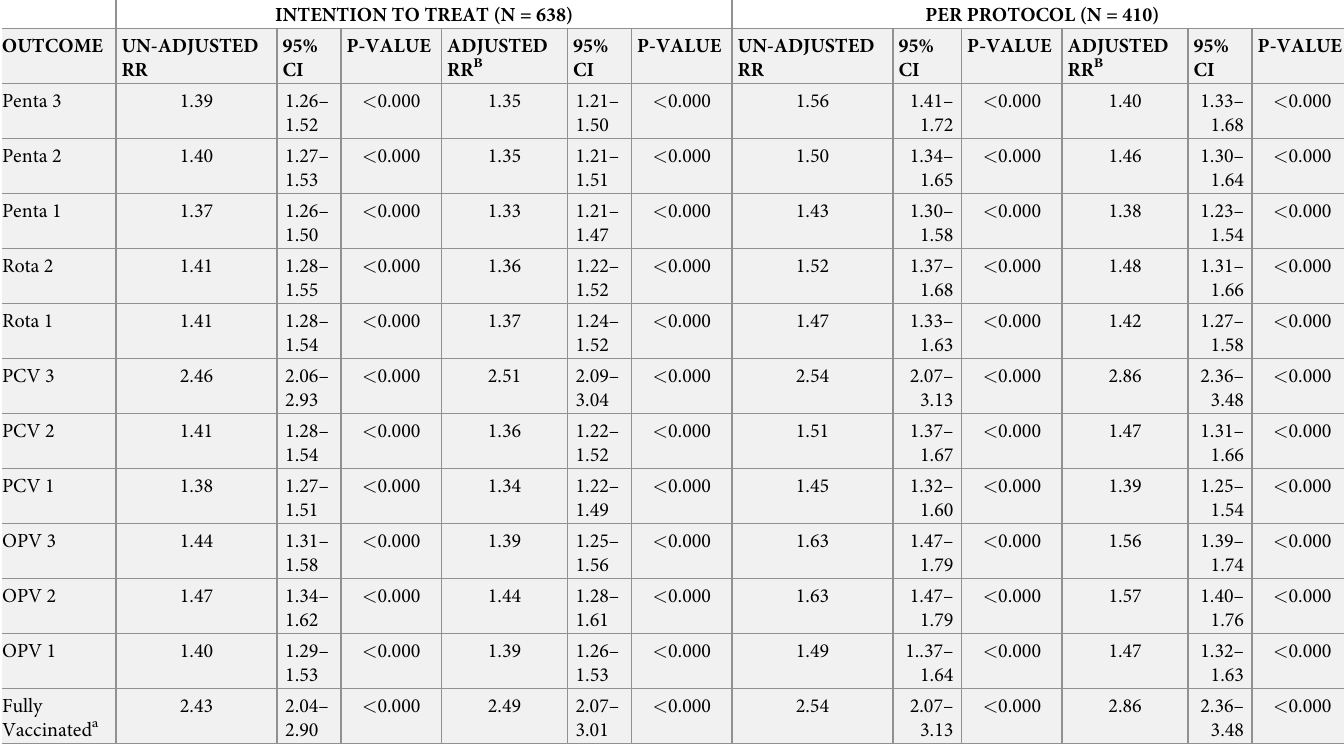
Table 3. Regression analysis for vaccination outcomes comparing the intervention to control